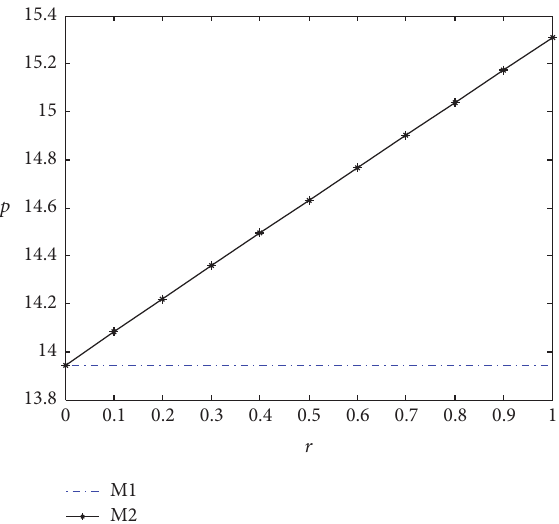
Figure 6: Optimal price comparison in models M1 and